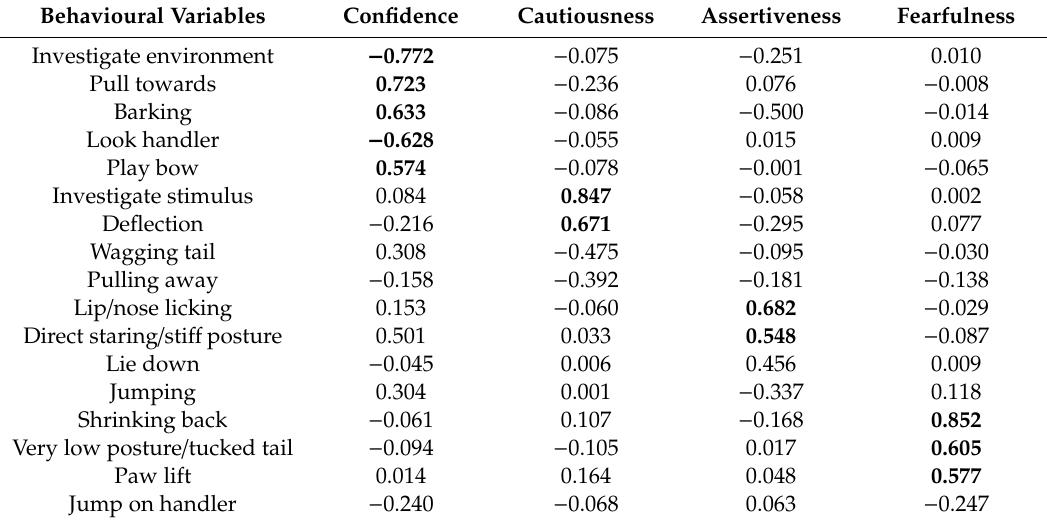
Table 2. Dimensions extracted by the PCA for the dog-dog interaction test behavioural scores. Loadings higher than 0.50 are in bold.